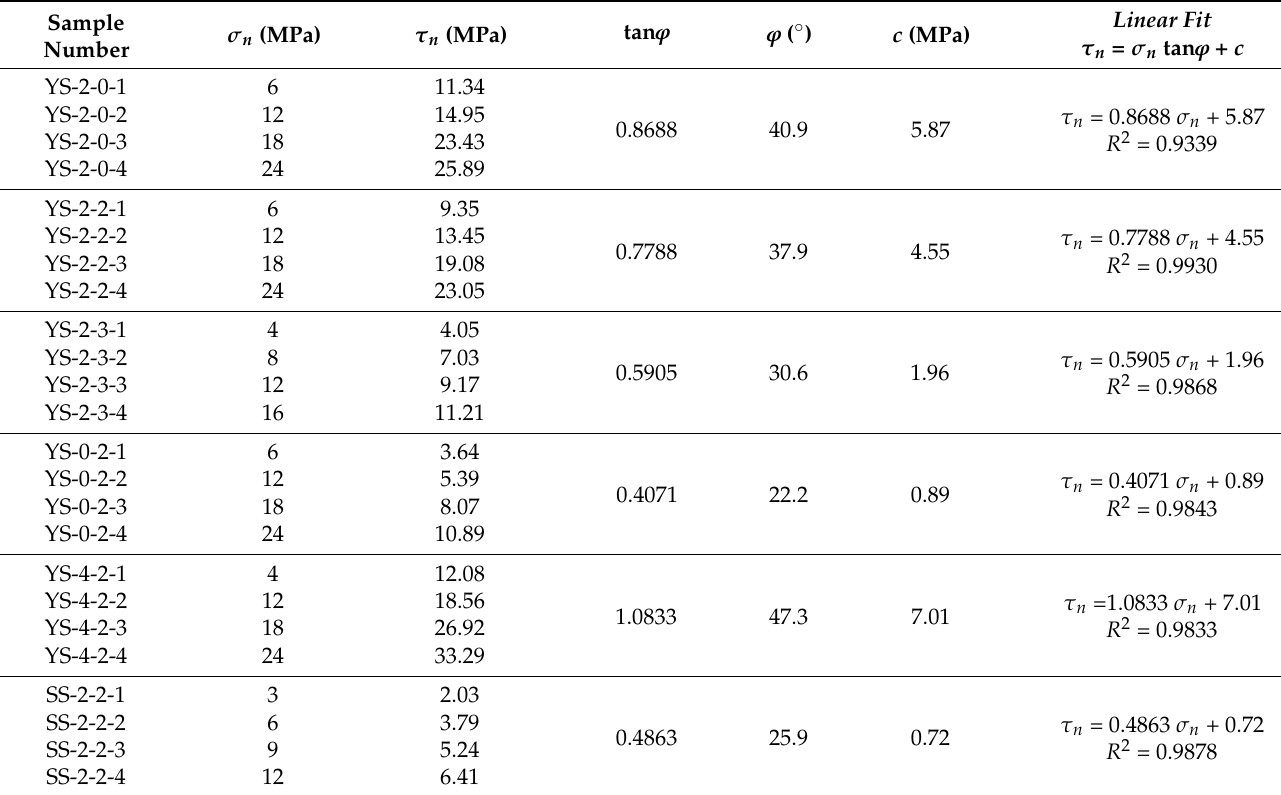
Table 5. Data collection of shear stresses and calculated parameters of shear